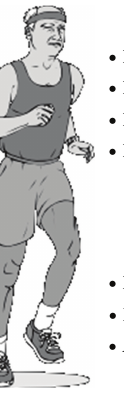
Figure 7: A few of the Metabolic benefits obtained through